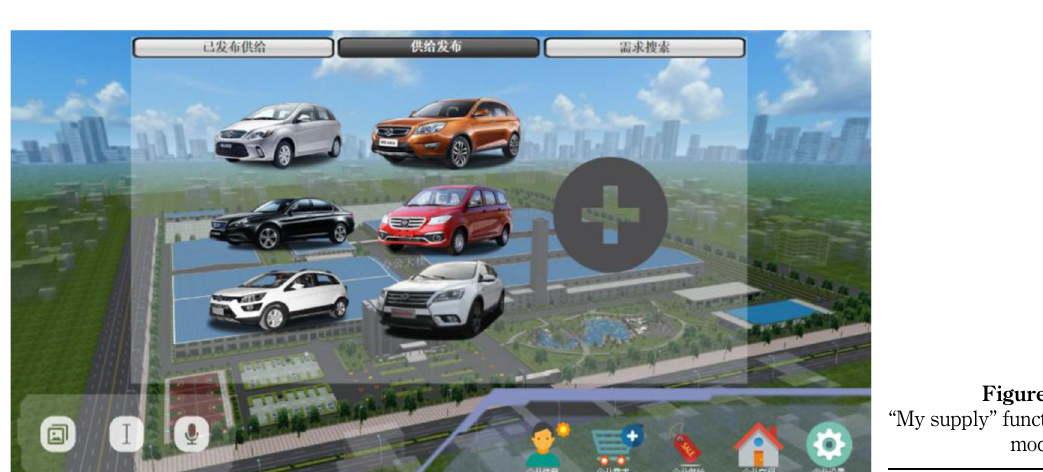
Figure 8. “ My demand